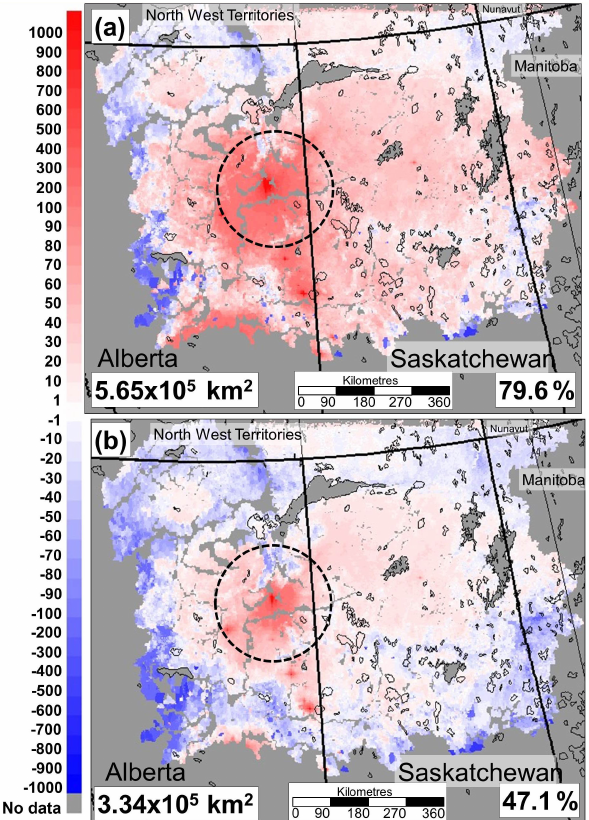
Figure 18. Predicted aquatic ecosystem critical load exceedances with respect to S dep , CLRTAP (2017) methodology (eqha − 1 yr − 1 ). (a) Exceedances with uncorrected model S dep . (b) Predicted ex- ceedances with model S dep corrected to match precipitation obser- vations. Circled region: 140km radius diameter circle around the Athabasca oil